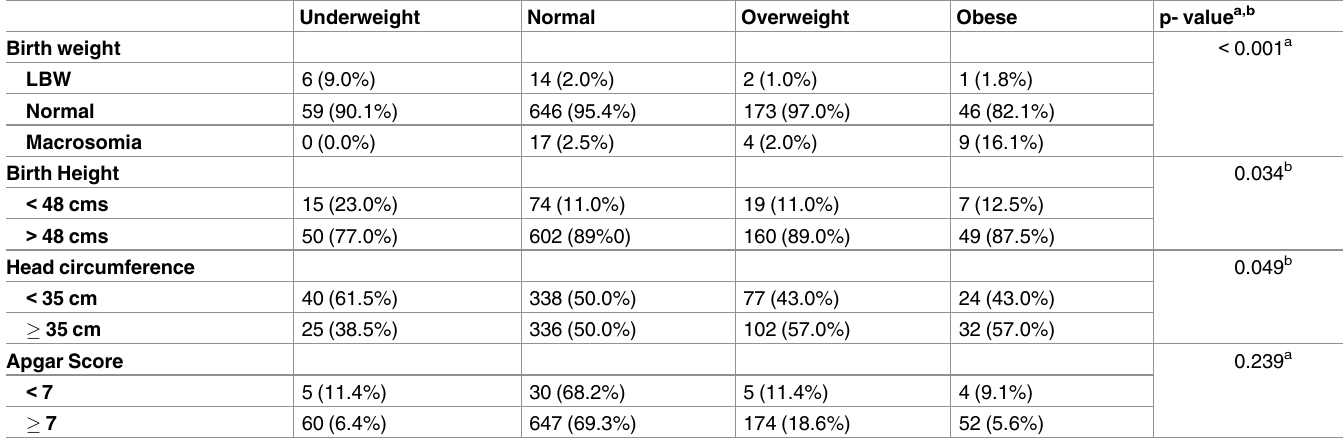
Table 6. Neonatal outcomes by pregestational BMI